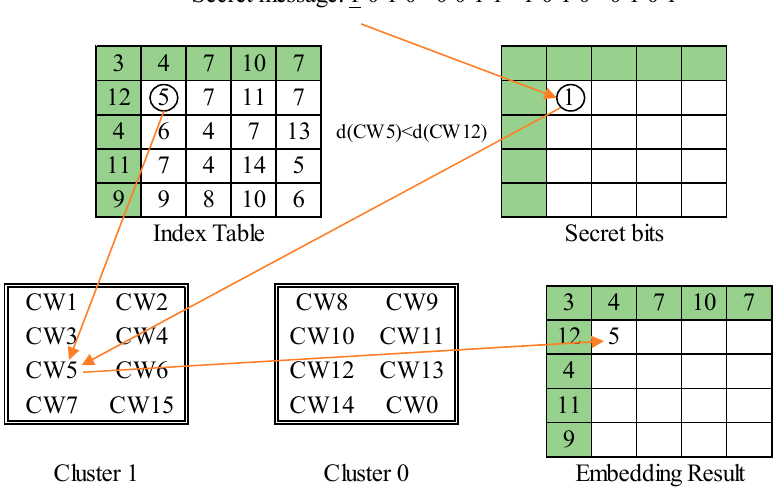
Figure 8. Embedding example 1: matched case.